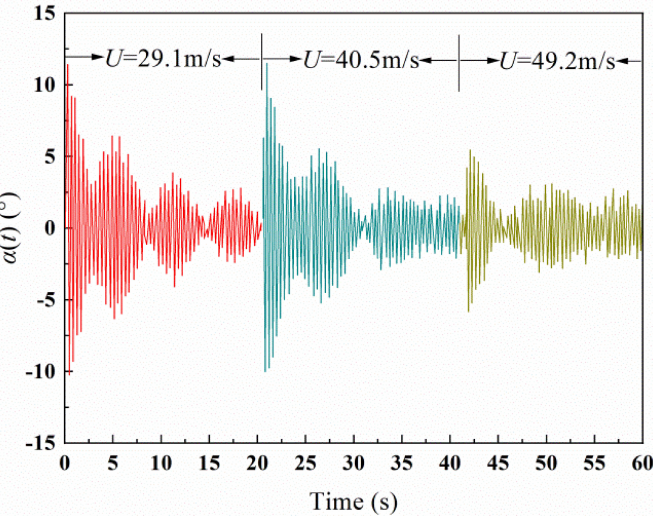
Figure 12. Beat vibration phenomenon of the wind-retaining plate section, − 3 ◦ angle of